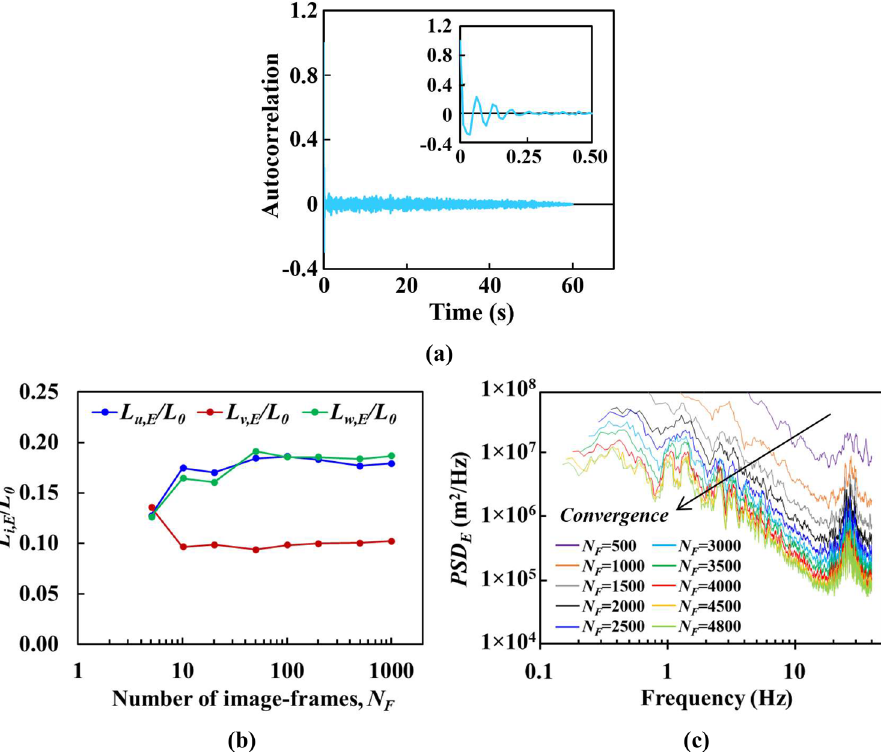
Figure 10. Illustration of ( a ) autocorrelation function of velocity fluctuations, convergence study of ( b ) equivalent integral length scale L i,E /L 0 and ( c ) equivalent power spectral density PSD E with increasing number of image-frames, N F —Case G at position TC within